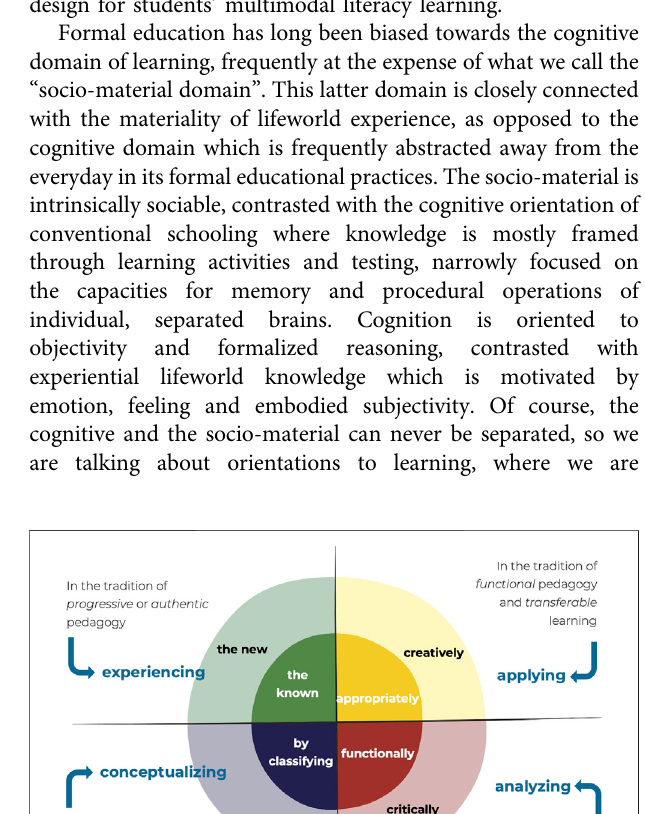
Frontiers in Communication |